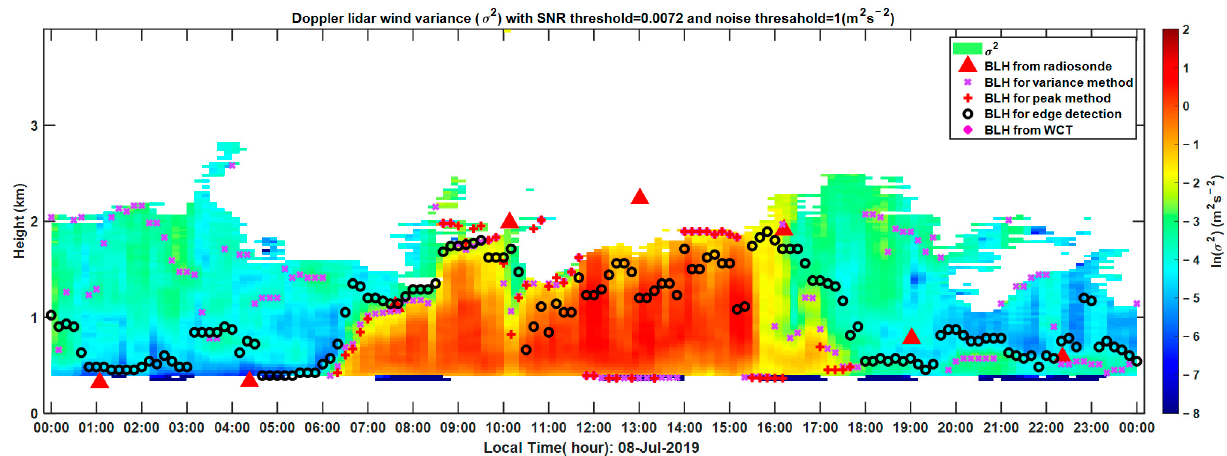
Figure 5. BLHs on 8 July 2019 obtained using the variance, peak, and ED methods compared with the RS measurements. The variance and peak methods performed poorly compared with ED at nighttime.